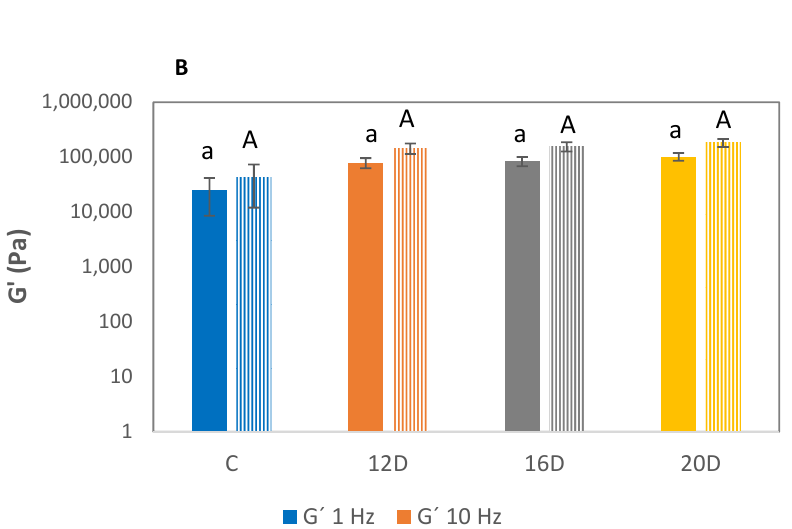
Figure 2. Mechanical spectra ( A ) and values of G′ at 1Hz obtained after dough fermentation ( B ). G′ (storage modulus—filled symbol), G″ (loss modulus—open symbol). C: control dough without whey; 12D: dough with 12% whey; 16D: dough with 16% whey; 20D: dough with 20% whey. Error bars indicate the standard deviations from the repetitions. Different letters (a, A) in the same graph correspond to significant differences (one-way ANOVA, p < 0.05).